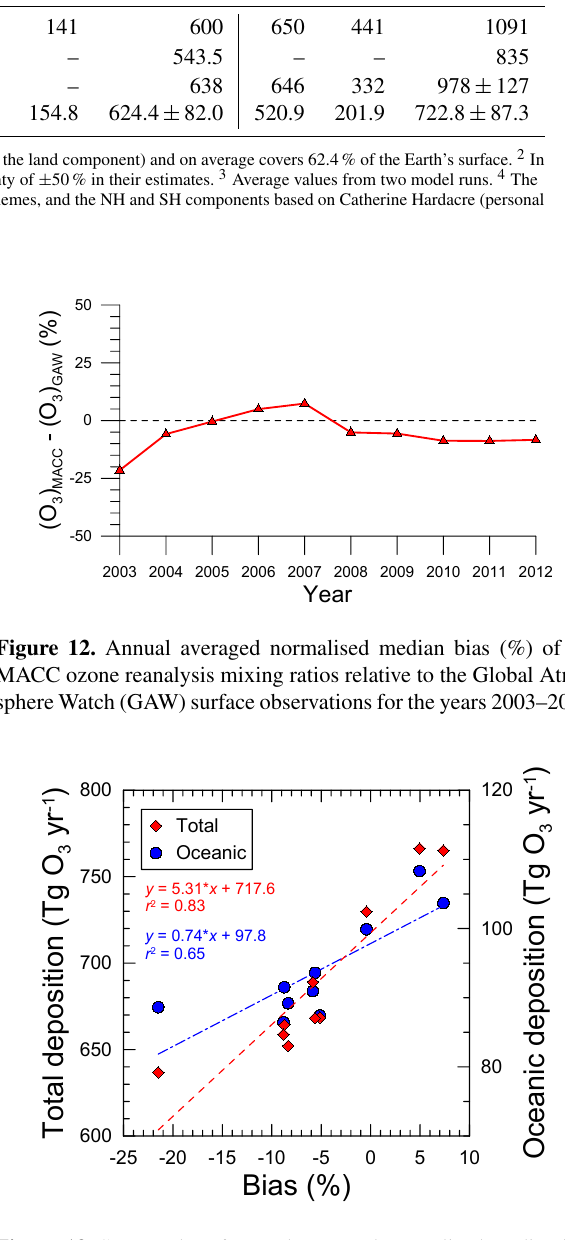
Figure 11. Annual variation in the dry deposition of ozone (TgO 3 yr − 1 ) obtained using the ACCESS-UKCA model (dotted lines) and the MACC reanalysis (solid lines): (a) the ocean compo- nent and (b) total. (NH: Northern Hemisphere; SH: Southern Hemi- sphere).